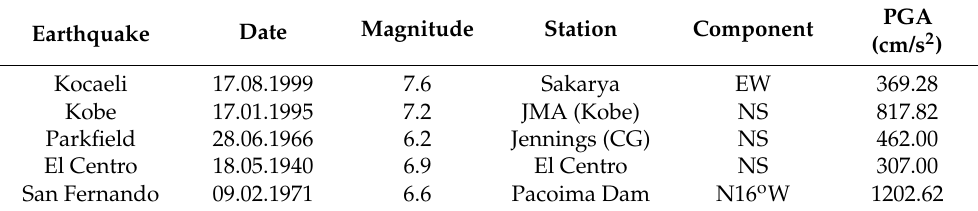
Table 2. Ground motion records used in the analysis.